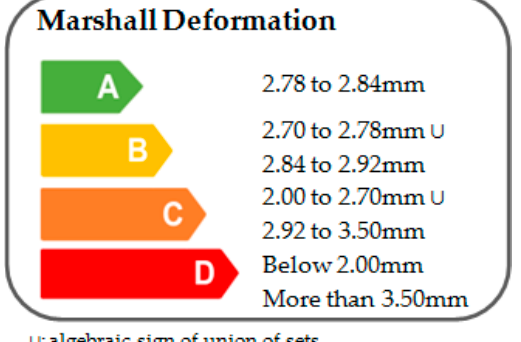
Figure 13. Marshall deformation global label.